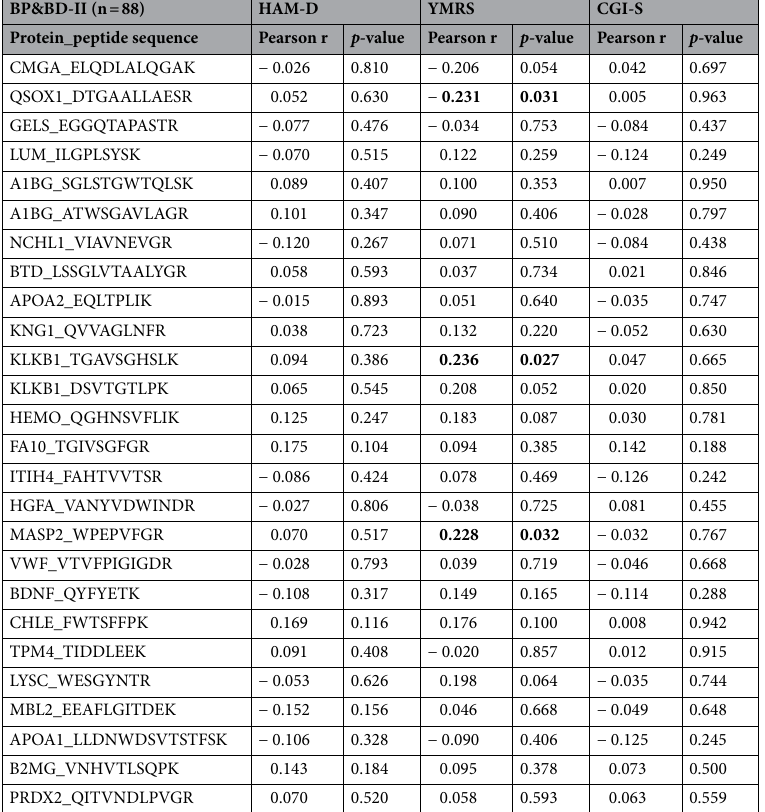
Table 3. Relationship between 26 peptides and demographic/clinical variables. Significant values are in bold. BP bipolar II prodrome, BD-II Bipolar II disorder, HAM-D Hamilton depression rating scale, YMRS Young mania rating scale, CGI-S Clinical global impression-severity